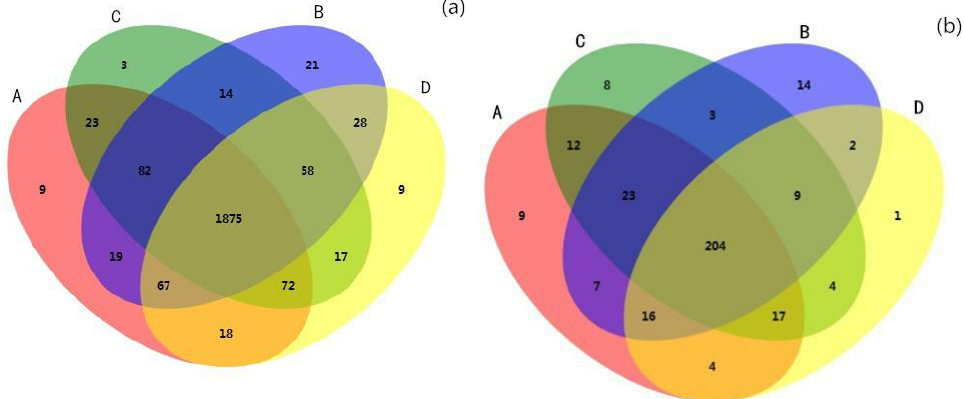
Figure 2. Venn diagrams based on OTUs of soil bacterial ( a ) and fungal ( b ) community with different forest management methods. A indicates close-to-nature forest management (CNFM), B indicates structure-based forest management (SBFM), C indicates unmanaged control (CK), and D indicate secondary forest comprehensive silviculture (SFCS).